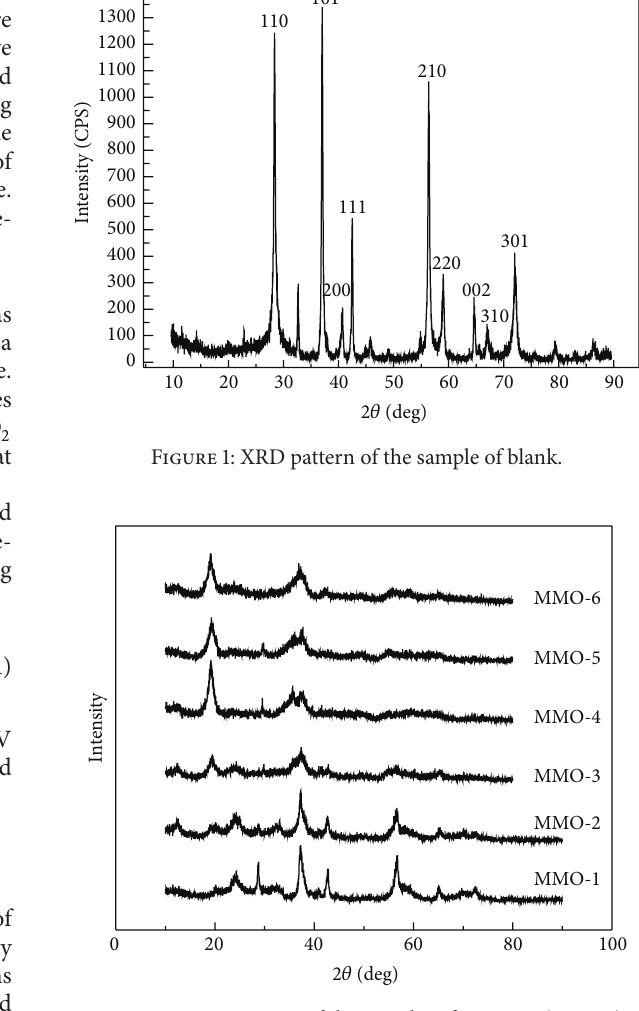
Table 1: Pore characteristics of the mesoporous MnO